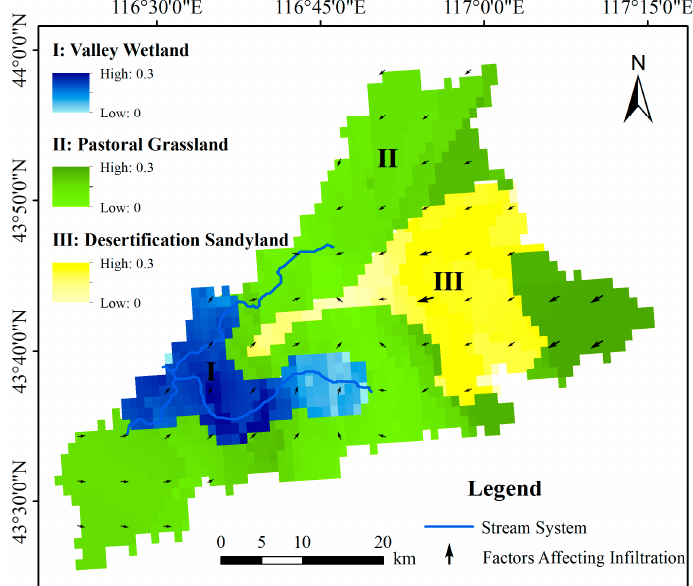
Figure 10. Map of the soil infiltration zones with the influence of soil and environmental factors, where the gradient color indicates the influence of soil properties and environmental factors on the infiltration process. The vector indicates the main influencing factors, where pointing to the first and third quadrants indicates that plants and moisture elements dominated, and pointing to the second and fourth quadrants indicates soil properties dominated.